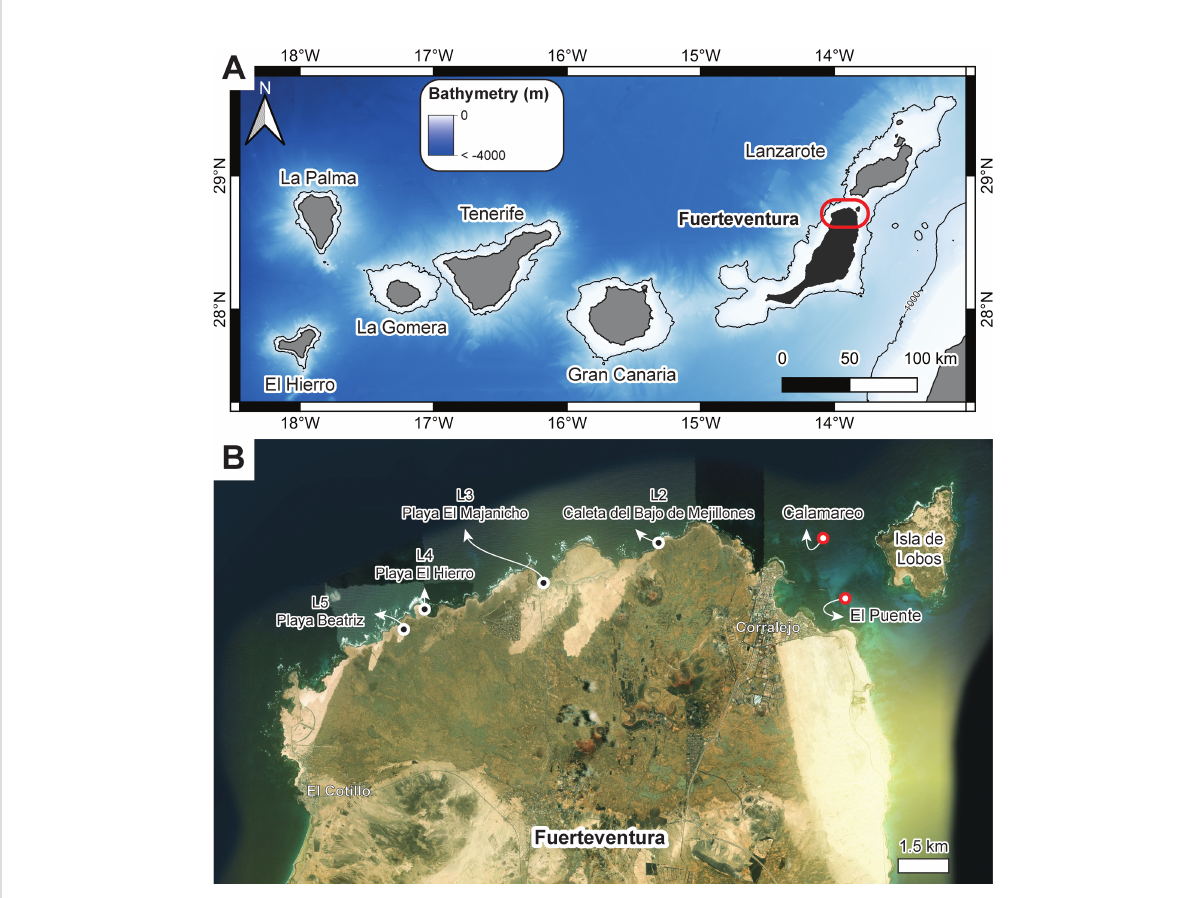
FIGURE 1 (A) Map of islands in the Canaries highlighting the study area in Fuerteventura, (B) Aerial view of the north coast of Fuerteventura Island showing the location of study sites between the towns of Corralejo and El Cotillo: L2 – Caleta del Bajo de Mejillones; L3 – Majanicho; L4 – Playa El Hierro; L5 – Caleta de Beatriz; Diving spot Calamareo; Diving spot El Puente, Bathymetry was retrieved from Gobierno de Canarias (https:// opendata.sitcan.es/dataset/modelo-digital-de-terreno-mdt-de-25x25-metros). Aerial photo from AppleMap